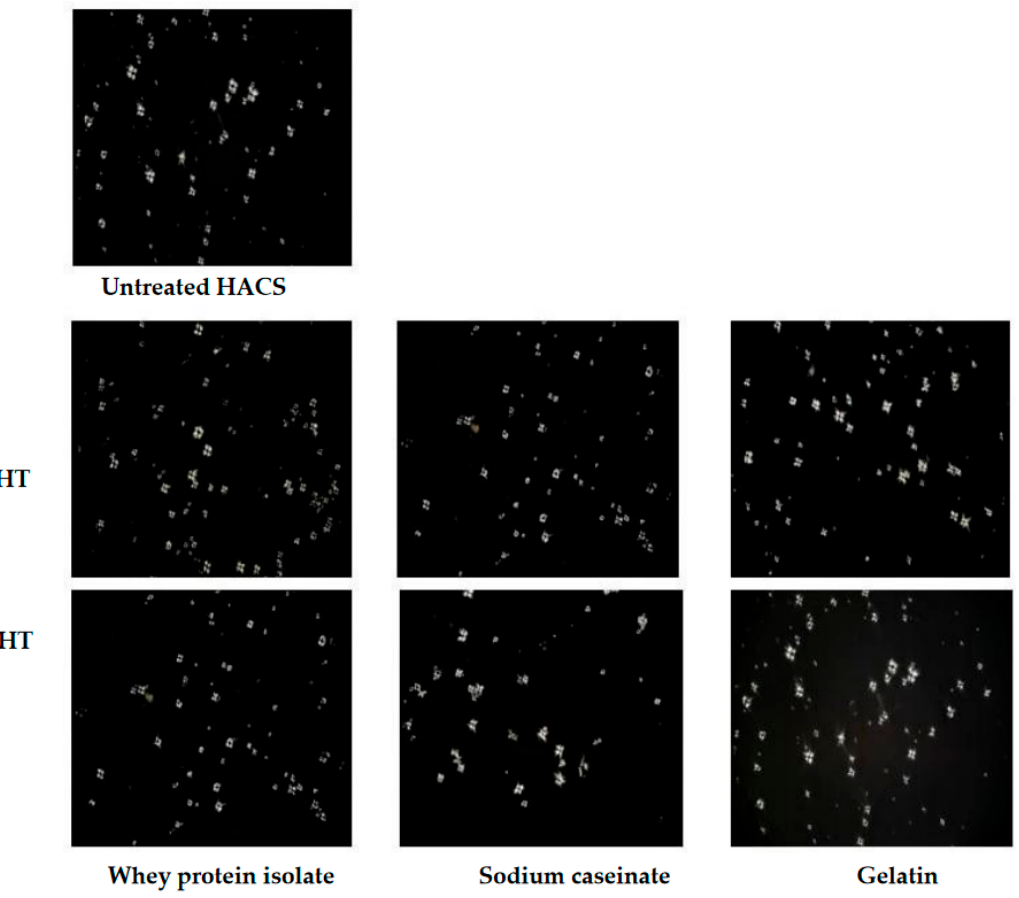
Figure 6. Light microscopy images captured for high amylose corn starch (HACS) and in combination with proteins prepared by the wet mixing method before and after dry heat treatment under a 50× lens.